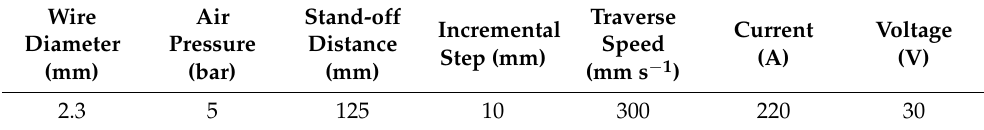
Table 2. Spray parameters used for the production of TWAS coatings.